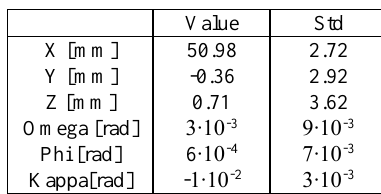
Table 2. Estimated relative orientation parameters between the two imaging sensors of Kinect v2